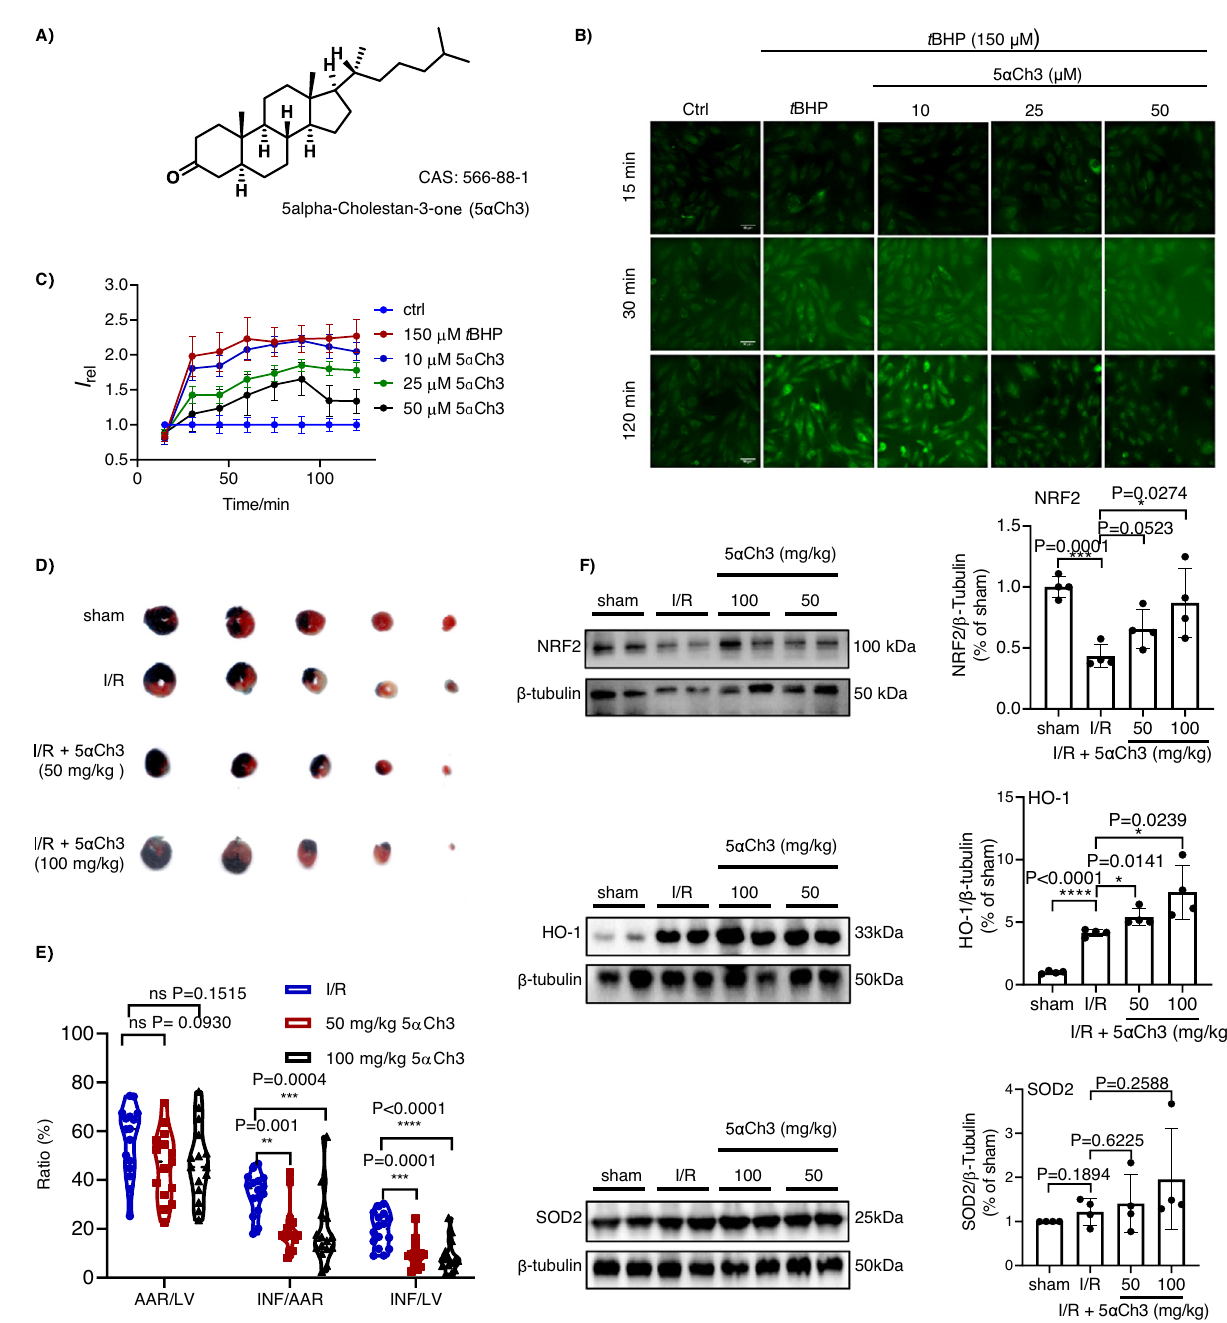
Fig. 6 | Verifying the effect of coprostanone to inhibit superoxide over- production and to ameliorate myocardial I/R injury in mice. A The molecular structure of coprostanone. B Representative images of H9C2 cells stimulated with t BHP and stained with F-Tz4 (1 μ M). Cells were intact (control), treated with t BHP (150 μ M),orpretreatedwithcoprostanone(10,25,50 µ M)for24handthentreated with t BHP(150 μ M).Allcellswereco-treatedwithprobe F-Tz4 atthetime t BHPwas adminstrated. Scale bar: 50 μ m. C The statistically quanti fi ed data on the cellular fl uorescence intensity of cells pretreated with coprostanone (24h) of different doses, and then treated with t BHP and F-Tz4 . The data were the mean±SD and were normalized to the control group. D Representative photographs of TTC staining of myocardial infarction in mice subjected to myocardial I/R injury with coprostanone pretreatment for 3 days before ischemia. All the mice were anes- thetized with tribromoethanol at a dose of 150mg/kg before surgery. Mice